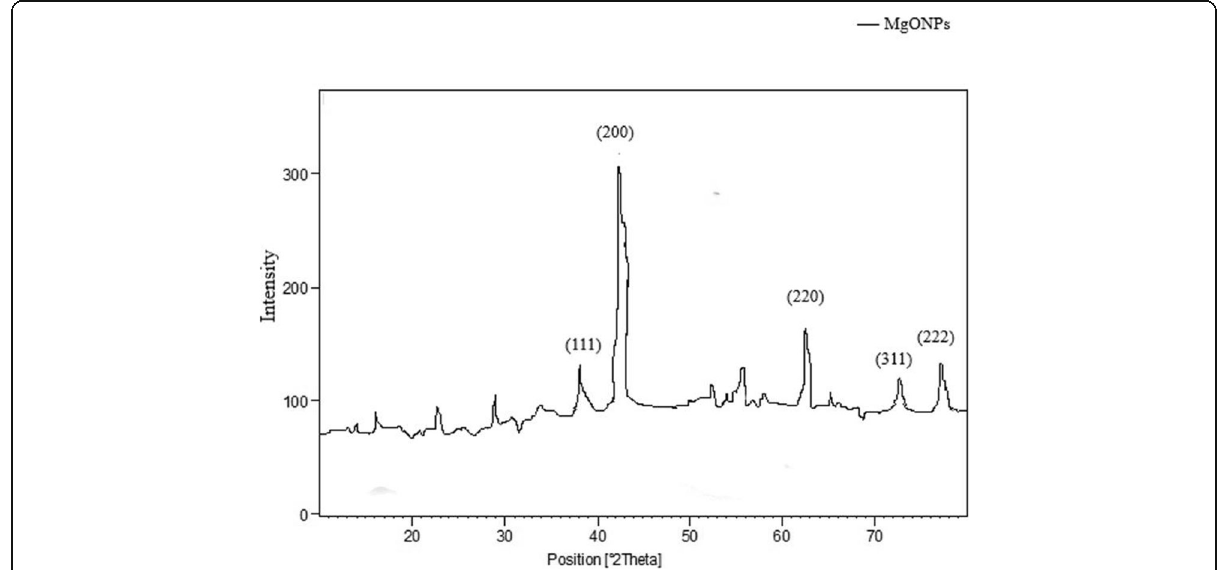
Fig. 2 XRD pattern of green synthesized MgO nanoparticles using P . marsupium heartwood